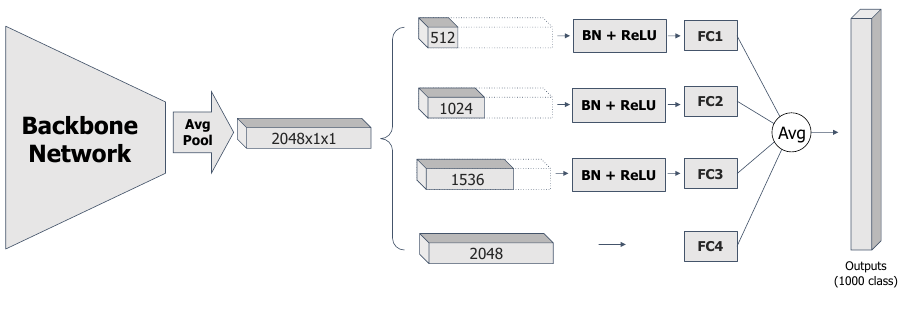
Figure 1. The illustrated example has 2048 channels in the final feature vector, and the output is 1000-class classification (An overview of SSM).